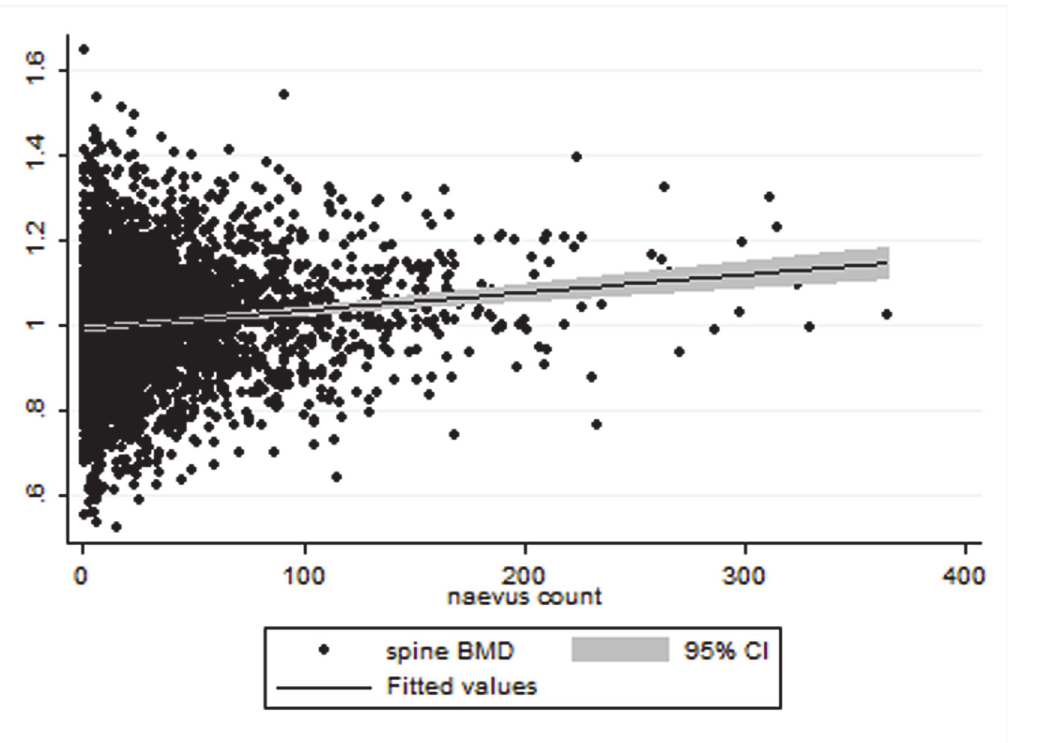
Figure 2. Scatter plot for Spine BMD (Y axis) referred to naevus count (X axis).